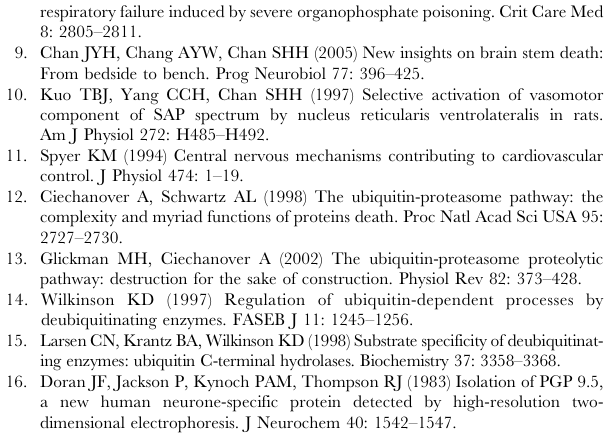
Figure S1 Synthesis of NOS II via transcriptional activation of NF- k B in RVLM. Representative gel depicting NF- k B DNA binding detected by EMSA in nuclear extracts from ventrolateral medulla of rats that received IV administration